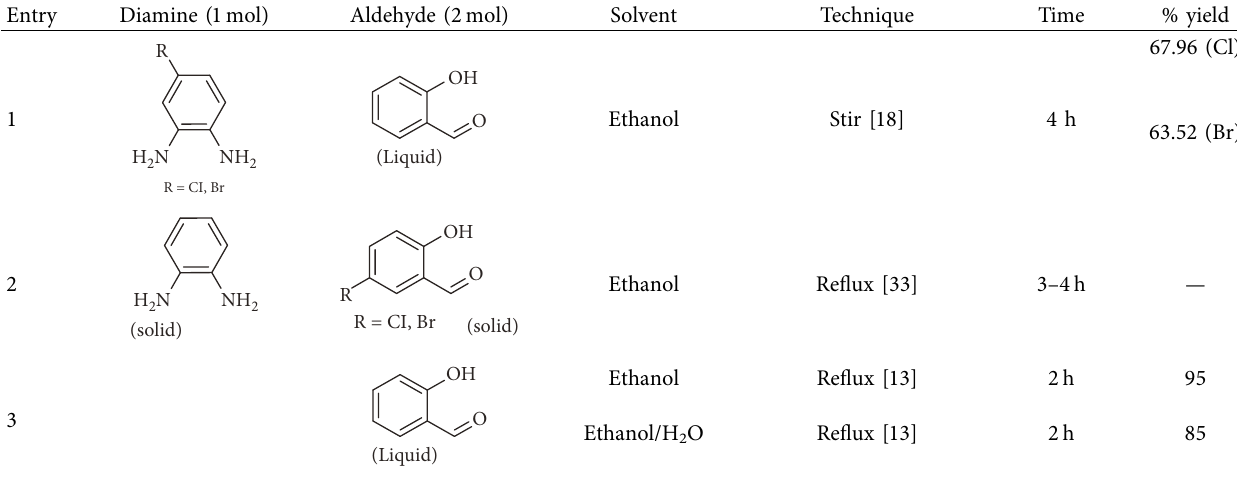
Table 3: Comparison of current azomethine synthesis to different reported